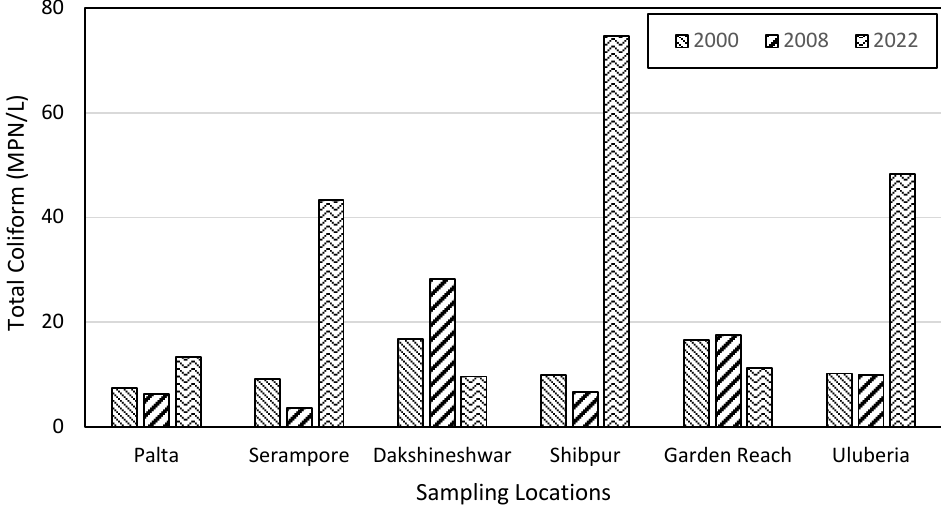
Figure 13. Variation of Total Coliform in different locations.